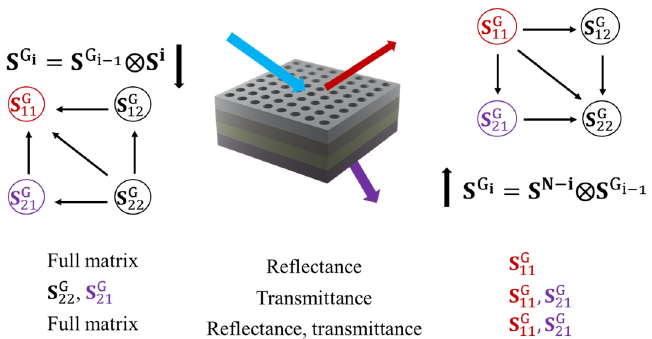
Figure 3. Recursive algorithm of constructing the global s-matrix, with the computational network representing the involvement of elements. The color nodes are the main interest, as they are used for characterizing optical responses. The bottom space represents the advantages of bottom-up versus top-down construction.